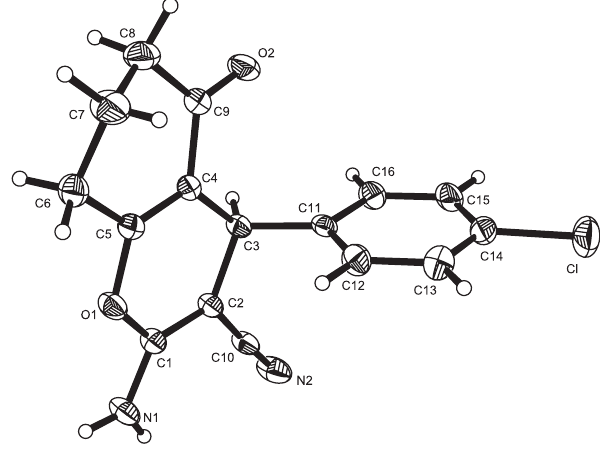
Table 1: Data collection and handling.